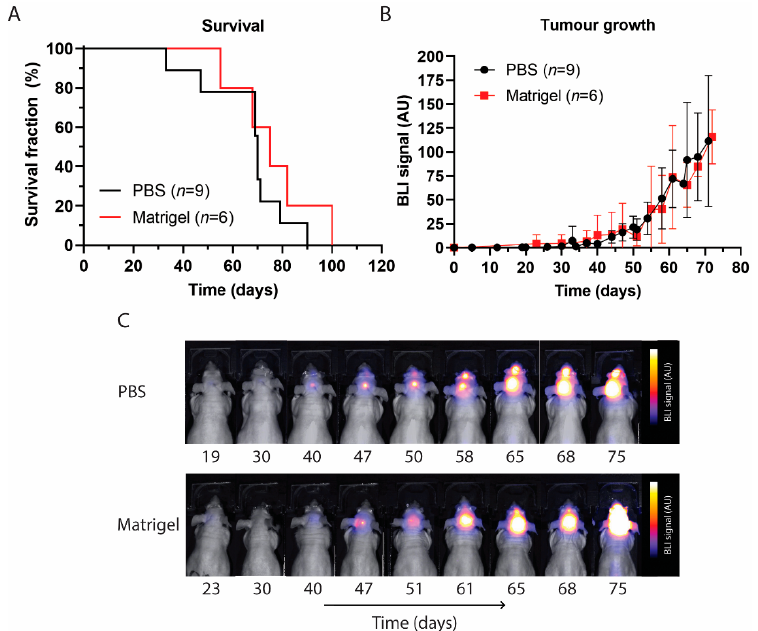
Figure 2. Survival and tumour growth following inoculation with HSJD-DIPG-007 cells suspended in PBS or Matrigel. ( A ) Kaplan–Meier curve showing survival following cell inoculation and tumour progression. No significant difference between PBS and Matrigel suspension groups was observed. ( B ) Tumour volume over time in both PBS and Matrigel suspension groups, showing that tumour growth was comparable up to 75 days. Data points are expressed as mean signal intensity ± SD. ( C ) BLI signal showing tumour growth over time. Tumour development within the pontine region, as well as metastatic development in the olfactory bulb region, can be seen in both PBS and Matrigel groups, progressing with time. AU = arbitrary unit.